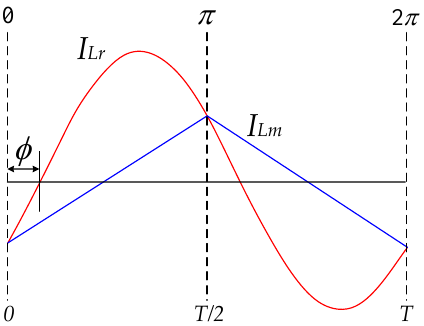
Figure 11. Resonant current waveform at f sw = f r .